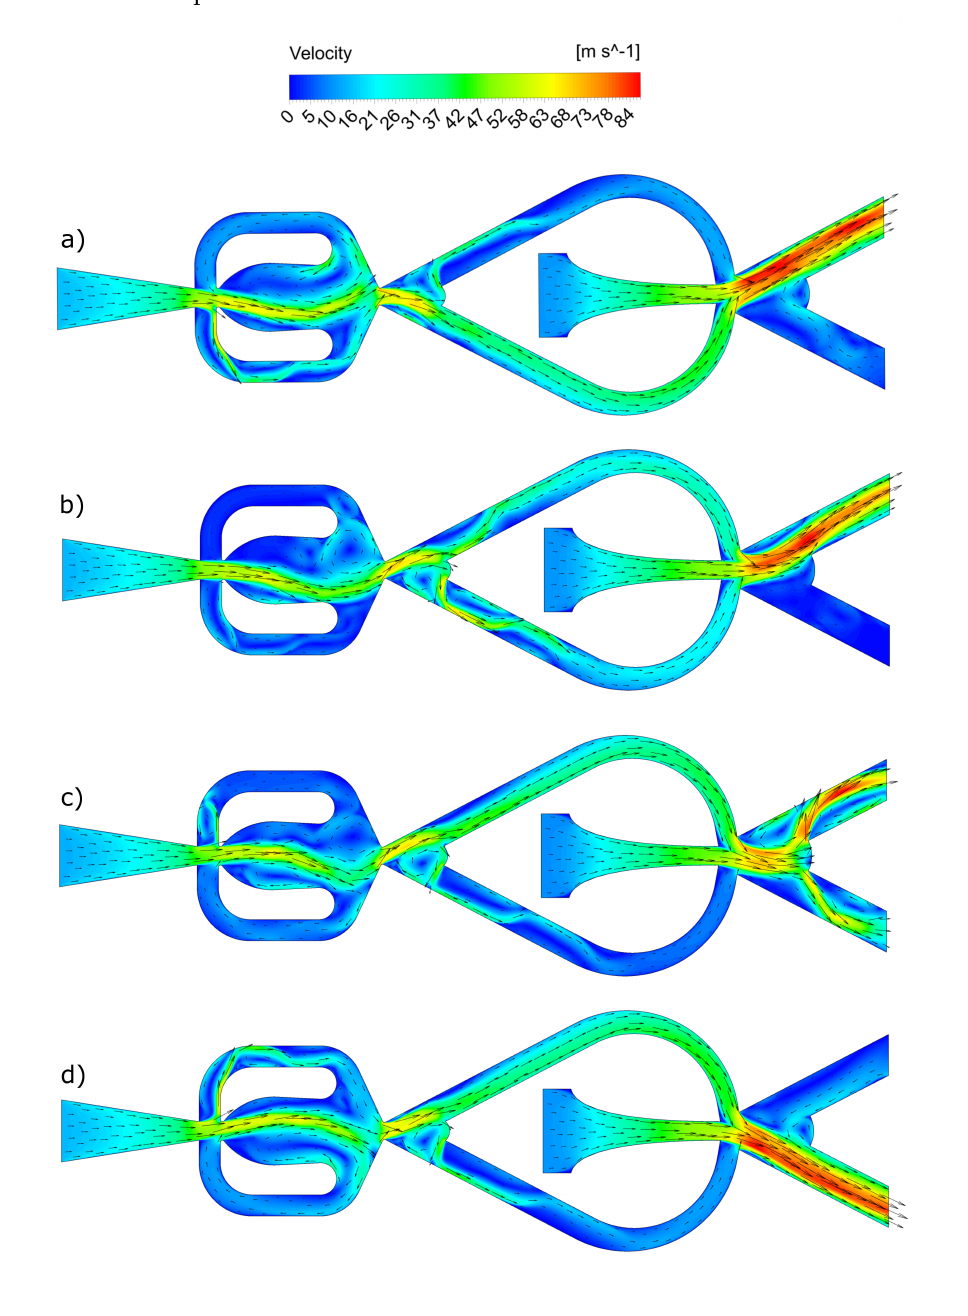
Figure 3. Numerical results for a 2D unsteady Reynolds-averaged Navier–Stokes (URANS) simula- tion of the actuator’s internal flow field ( a – d ) from top to bottom: ( a ) stable condition top output; ( b ) the oscillator output is switching to the upper control channel, the amplifier flow is beginning to detach from the top attachment wall; ( c ) the oscillator flow is fully switched to the upper control channel and the amplifier flow is in the process of switching; ( d ) stable condition bottom